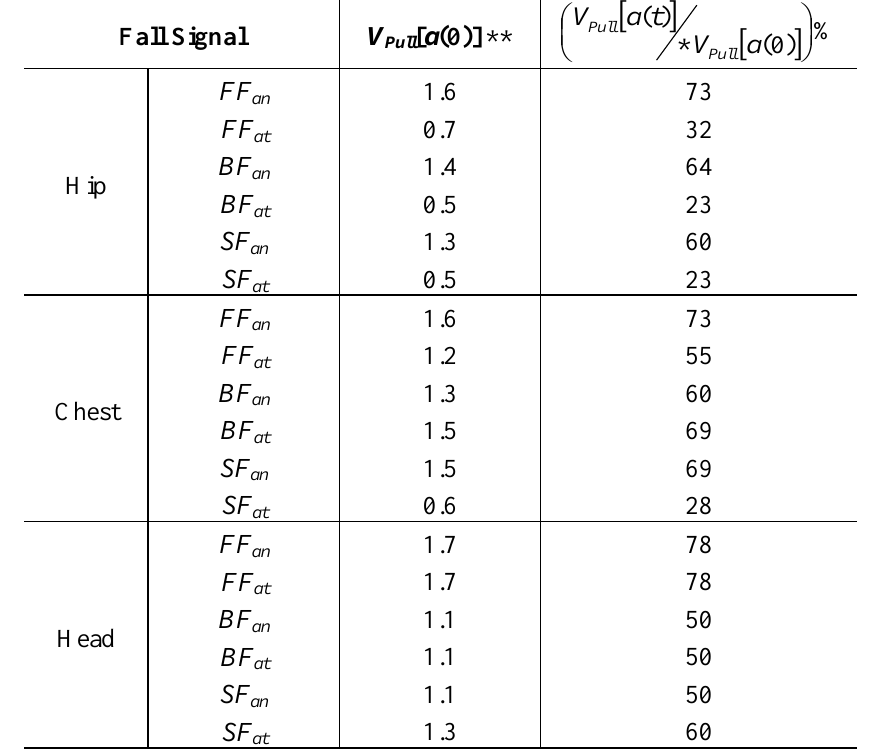
Table 9. Pull in voltage for each fall signal. * pull in voltage due to the electrostatic force without the effect of the fall acceleration, ( V [ a (0)]) = 2.18 V . ** pull in voltage due to Pull the electrostatic force with the fall